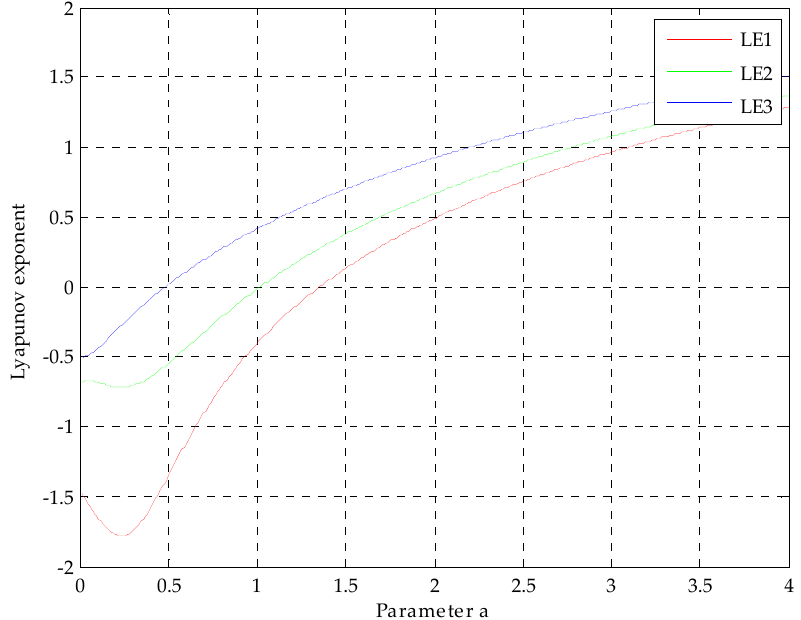
Figure 2. Exponential Lyapunov spectrum of system (2).